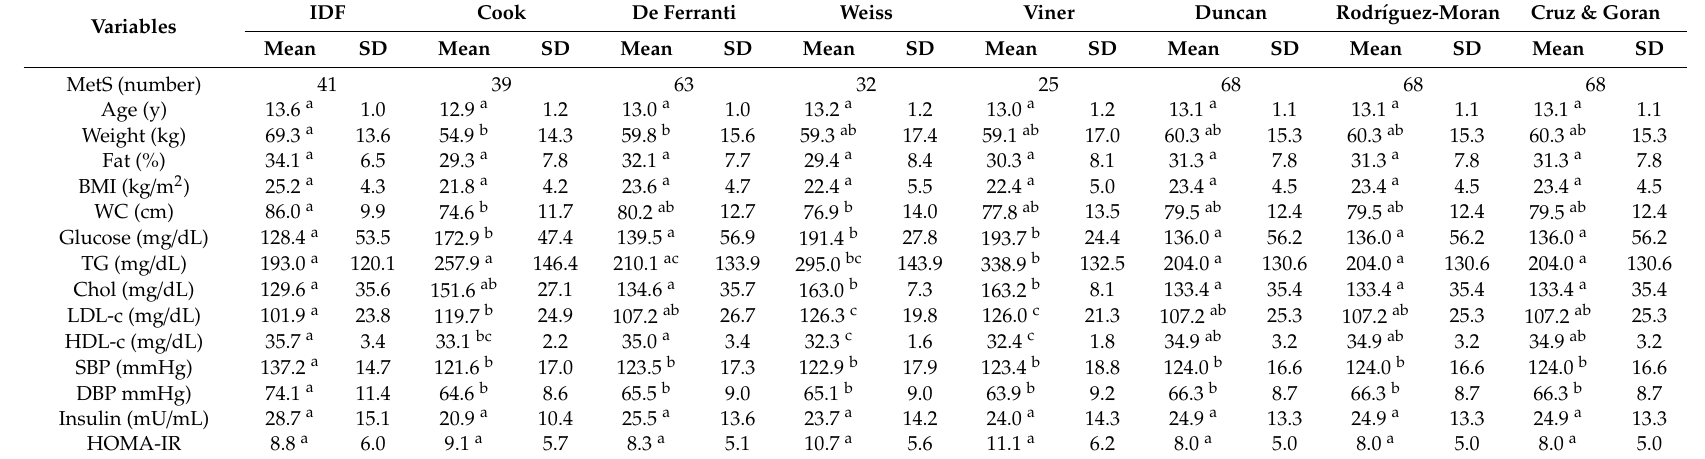
Table 3. Characteristics of boys diagnosed of MetS according to the di ff erent diagnostic